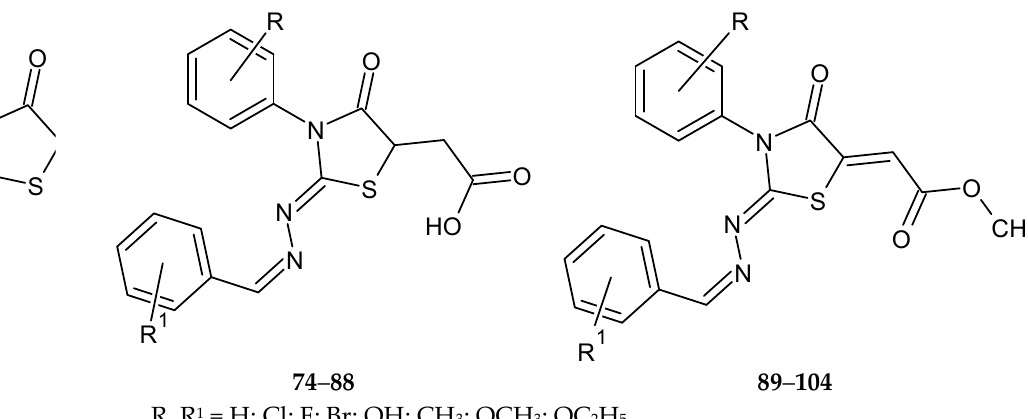
Figure 11. The structure of new thiazolidin-4-one derivatives.